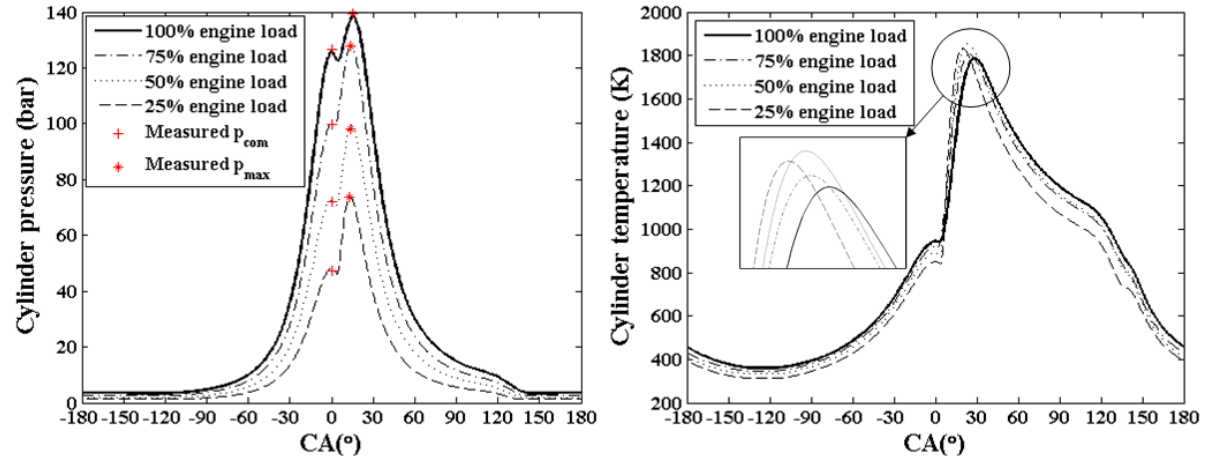
Figure 4. In-cylinder pressure and temperature variations at various